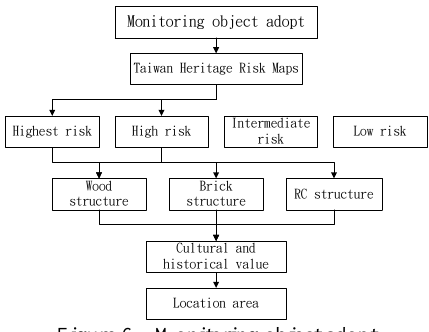
Figure 6 、 Monitoring object adopt